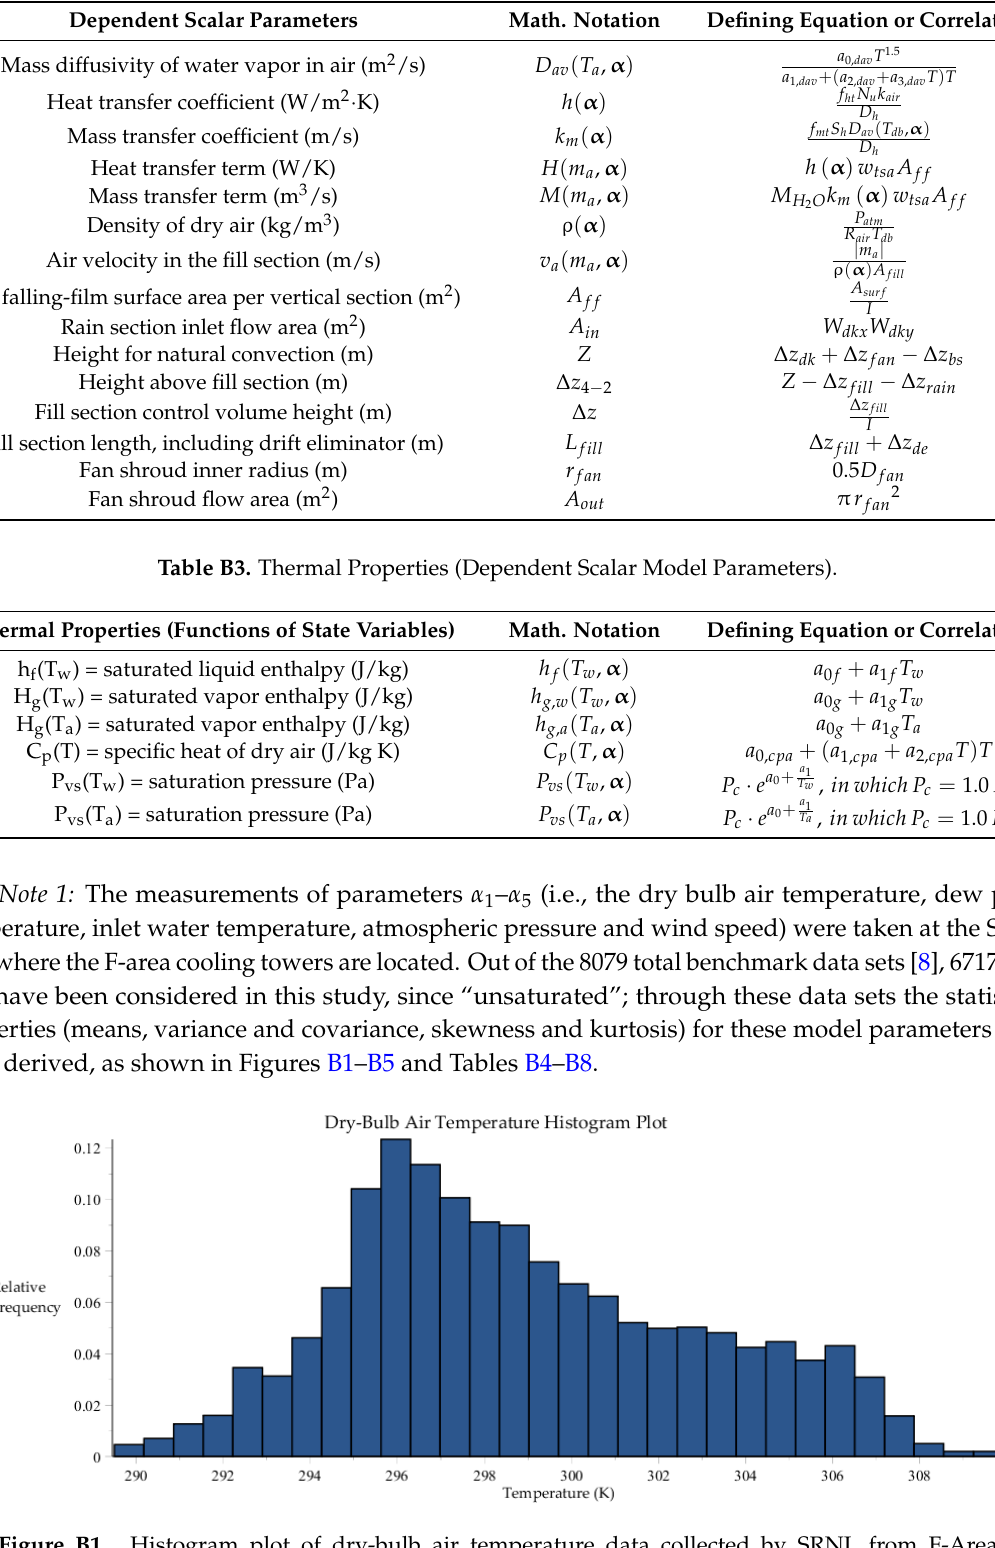
Figure B2. Histogram plot of dew-point air temperature data collected by SRNL from F-Area cooling towers.